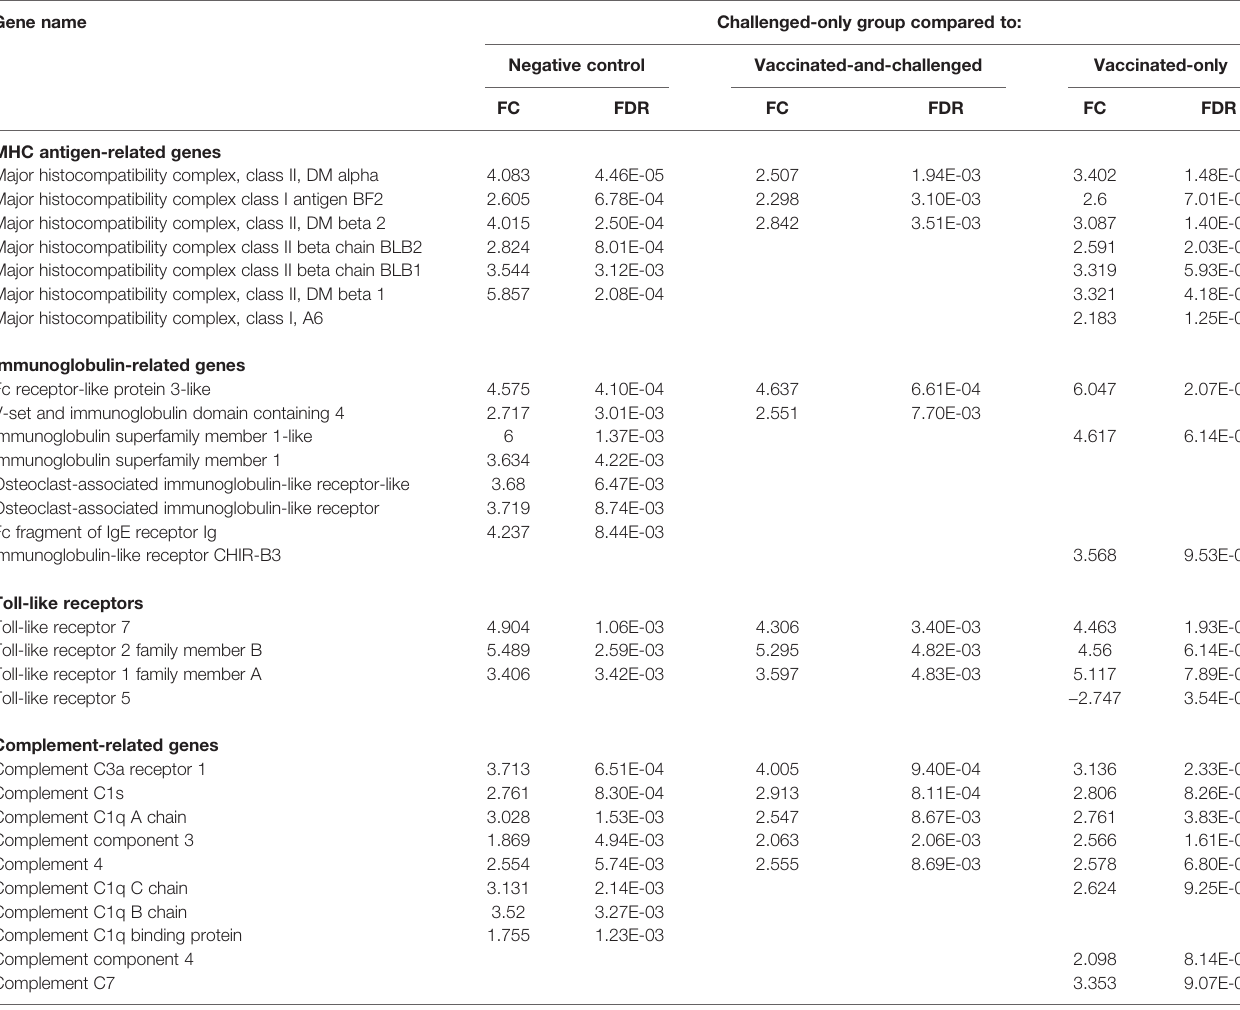
TABLE 4 | Log 2 fold changes (FC) and false discovery rates (FDR) of differentially expressed MHC and other immune response-related genes in the challenged-only group compared to the other